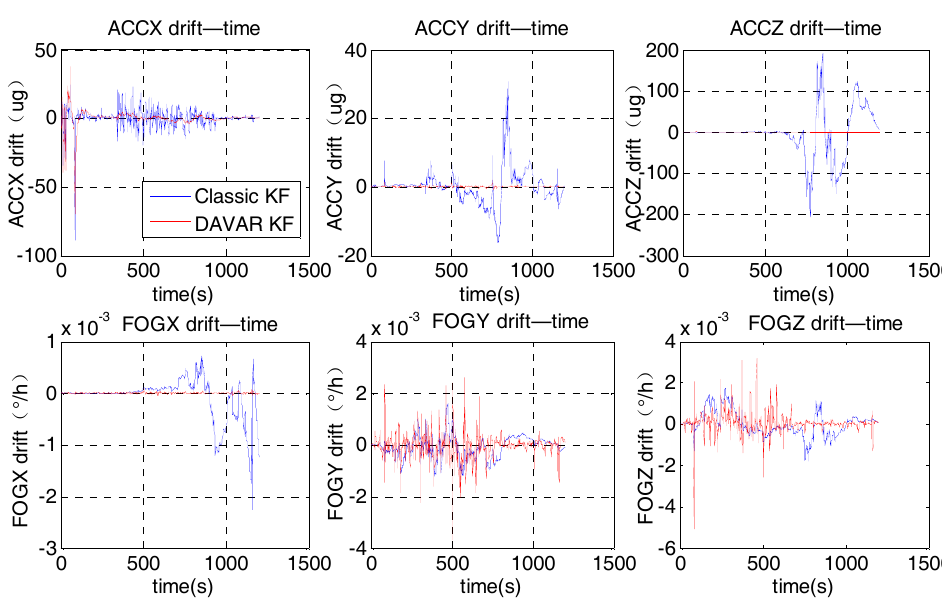
Figure 11. Estimate drifts of FOGs and ACCs.